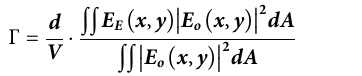
TABLE 3 The speci fi c structural parameters of the phase